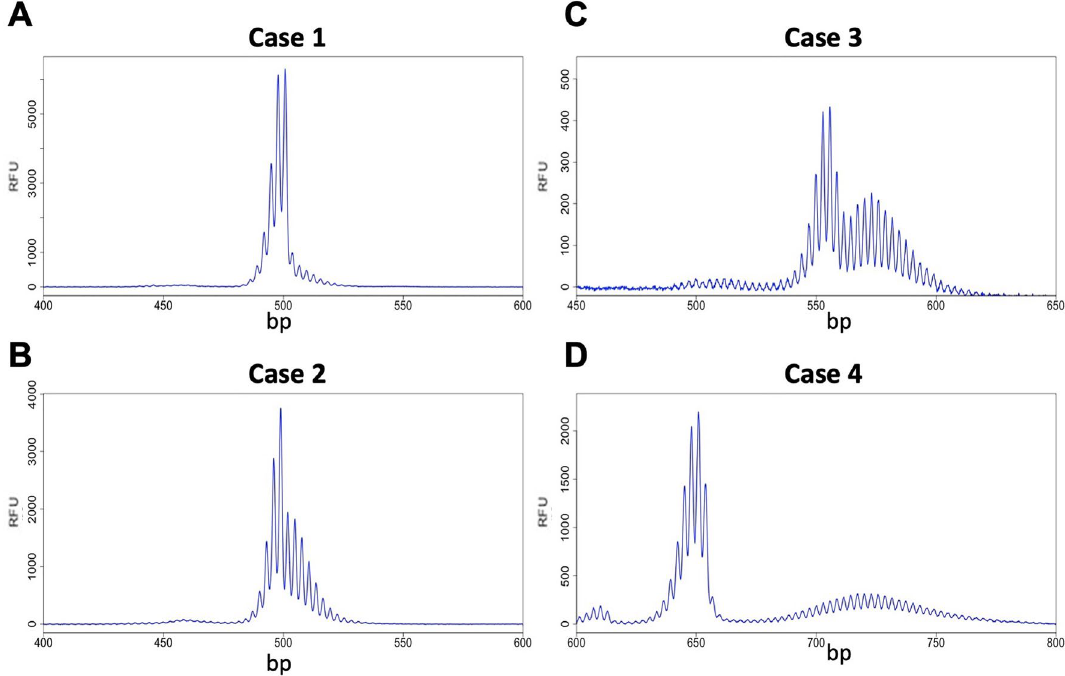
Figure 2. Examples of different types of PCR profiles observed in female PM carriers. Capillary electrophoretograms for 4 different females focusing on the PM allele size range showing the profiles for a stable allele (case 1) and three alleles with increasing levels of somatic